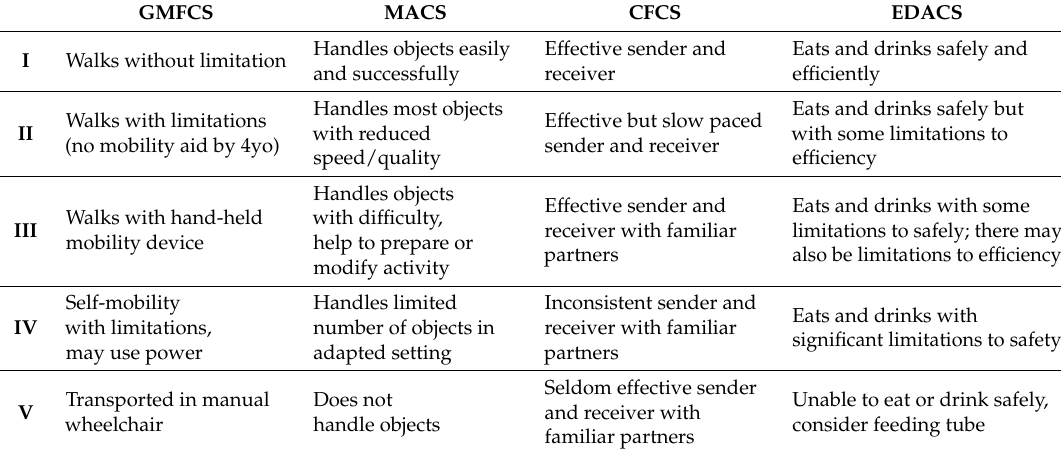
Table 1. Five classification levels of the Gross Motor Functional Classification System (GMFCS), the Manual Ability Classification System (MACS), the Communication, Function Classification System (CFCS) and the Eating and Drinking Ability Classification System